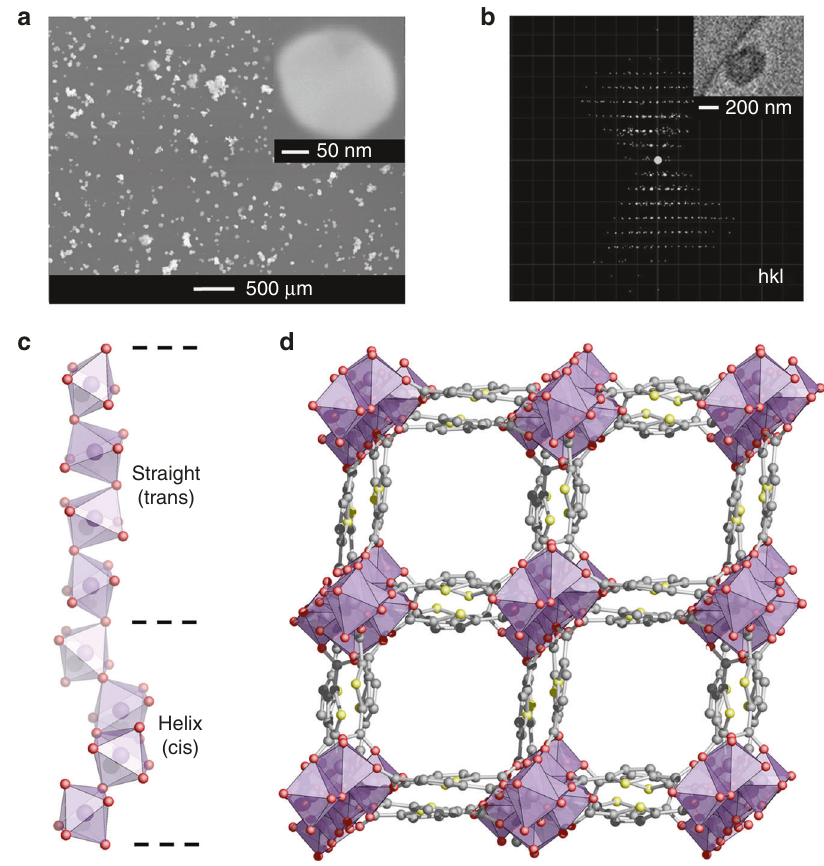
Fig. 1 Determination and details of the crystal structure of CAU-23. a SEM image of CAU-23. b Reconstructed 3D reciprocal lattice from cRED data of a nano-sized single-crystal (inset) of CAU-23. c The repetition of cis and trans corner-sharing AlO 6 polyhedra forming the inorganic building unit of CAU-23. d The full structure of CAU-23 projected along [010]; water molecules are omitted for